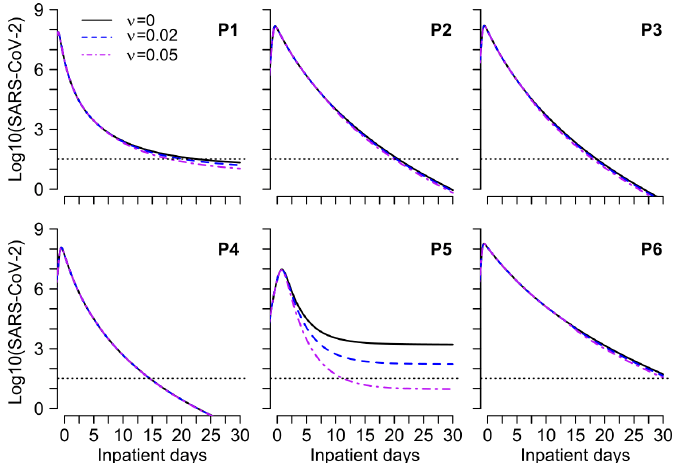
Figure 5. The slight impact of binding effects of nucleocapsid IgG antibodies on nasal viral dynamics. The solid black line represents the best fits to the observed data (using parameter values in Table S4 estimated under model MP-v2 in Table S3), the dashed blue line representing the case when we assume weak binding effects ( 𝜈 = 0.02 ), and the dashed-dotted purple line represents strong binding effects ( 𝜈 = 0.05 ).